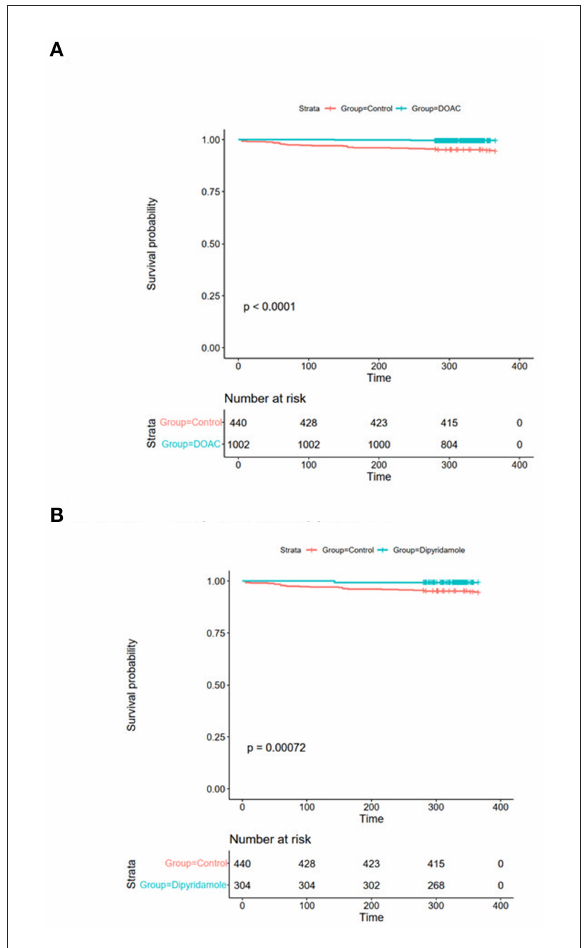
FIGURE3 Kaplan-Meier plots of all-cause survival probability (A) DOAC: 1.1% vs. Ctrl.: 5.7%, OR 0.19 (95% CI 0.07–0.55), p = 0.001 and (B) Dipyridamole: 1.2%, Ctrl.: 5.7%, OR 0.20 (95% CI 0.05–0.86), p = 0.023.